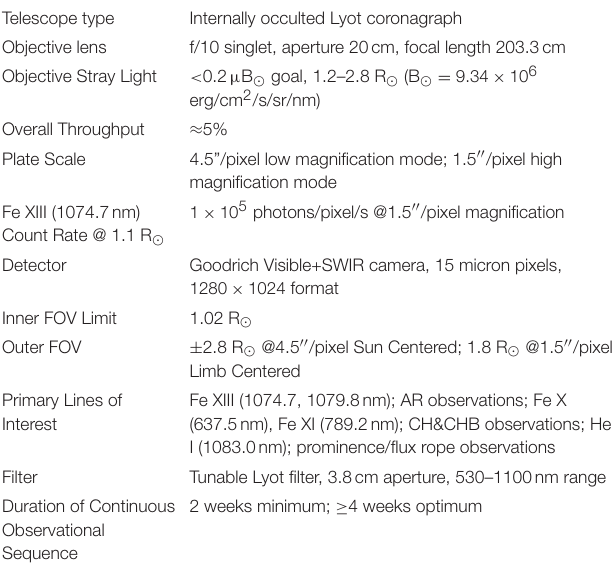
TABLE 1 | WAMIS long duration balloon instrument characteristics. Telescope type Internally occulted Lyot